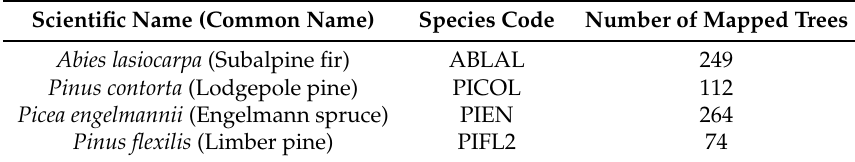
Table 1. Tree species recorded at the NIWO NEON site for all sampling plots combined in the woody vegetation structure data